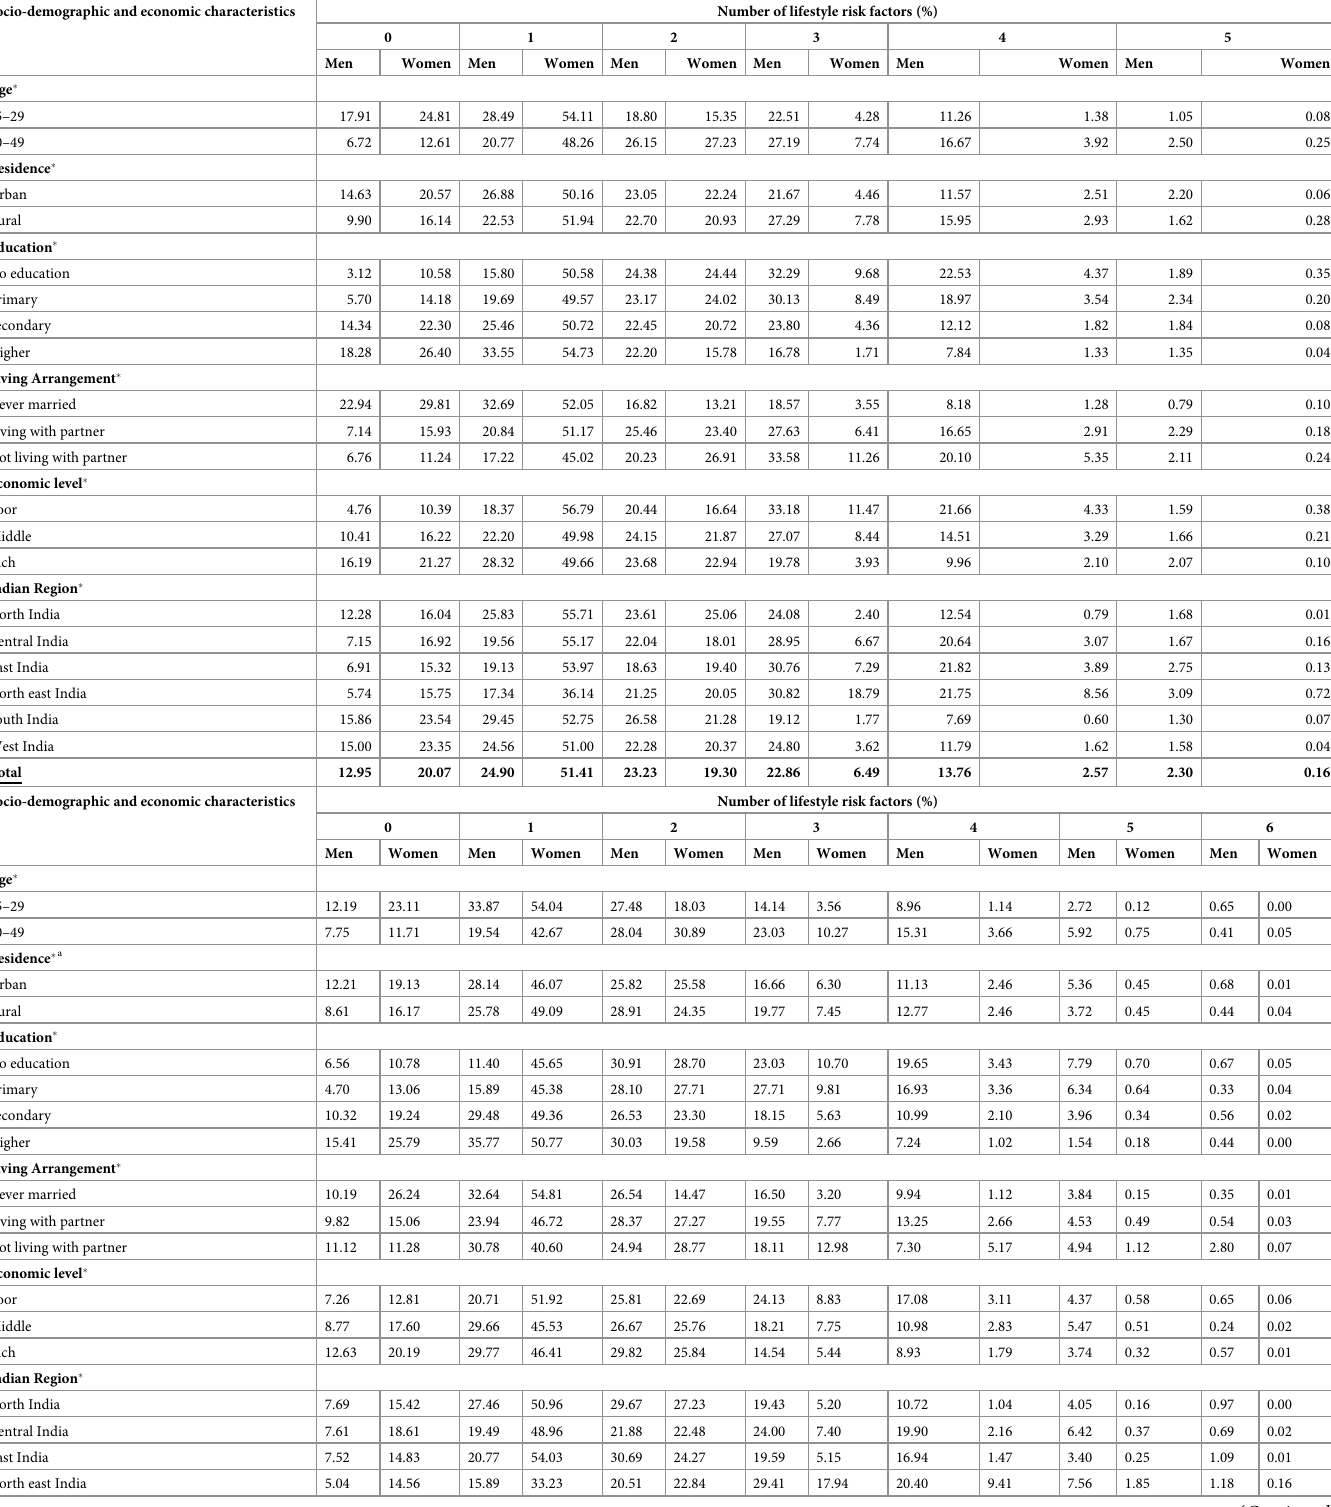
Table 3. a. Prevalence of co-occurrence of non-communicable disease risk factors by socio-demographic and economic characteristics during 2005–06. b. Preva- lence of co-occurrence of non-communicable disease risk factors by socio-demographic and economic characteristics during 2015–16 . Socio-demographicandeconomiccharacteristics Numberoflifestyleriskfactors(%)